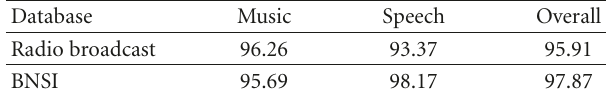
Table 6: Accuracy results (in %) for speech/music segmentation for multifeature discriminator.